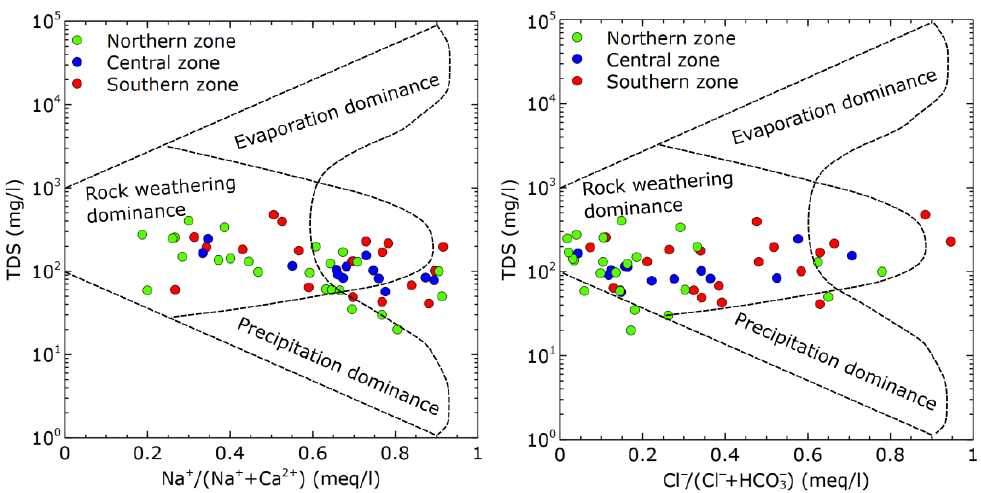
Figure 11. Gibbs diagram [47] for groundwater samples used to determine the main controls of water chemistry highlight rock weathering as the main mechanism controlling groundwater chemistry in the Pra Basin.